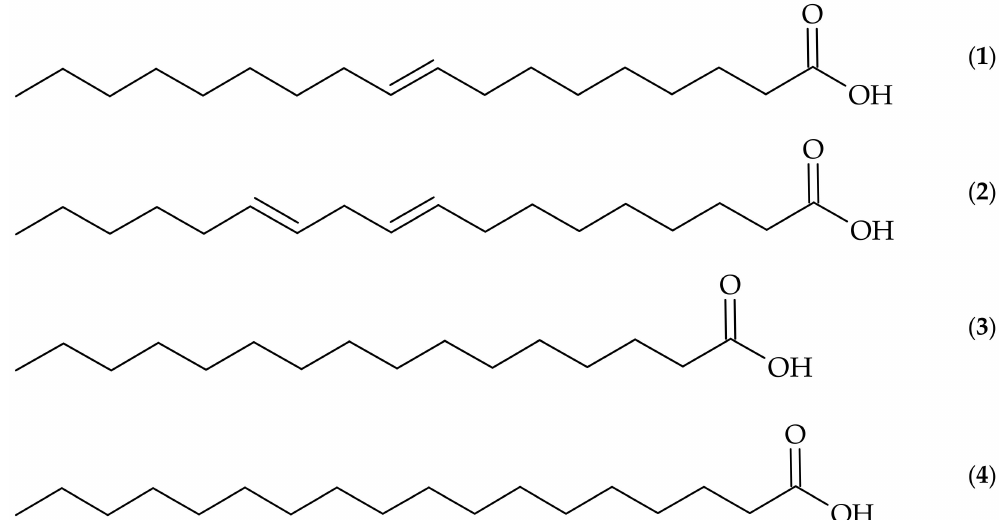
Figure 1. Structures of the constituents identified in the extracts of Annona squamosa : ( 1 ) oleic acid; ( 2 ) linoleic acid; ( 3 ) palmitic acid; ( 4 ) stearic